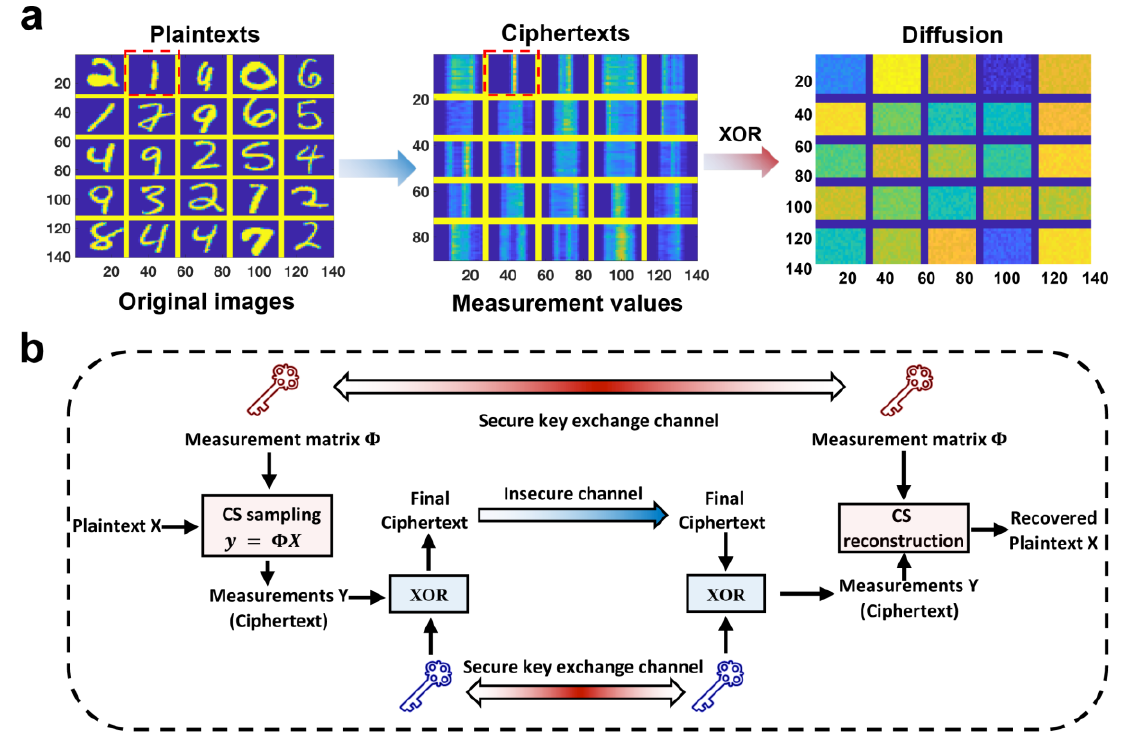
Figure 11. An XOR diffusion operation to implement a secure all-in-one compression and encryption system. ( a ) The original signals (plaintext), the measurements (ciphertext), and diffusion result by XOR. The measurements after CS expose edge features and a diffusion operation makes the edge in- formation hidden. ( b ) Schematic diagram of a perfectly secure all-in-one compression and encryption engine system based on CS. Reproduced with permission [91] Copyright 2023, Wiley −